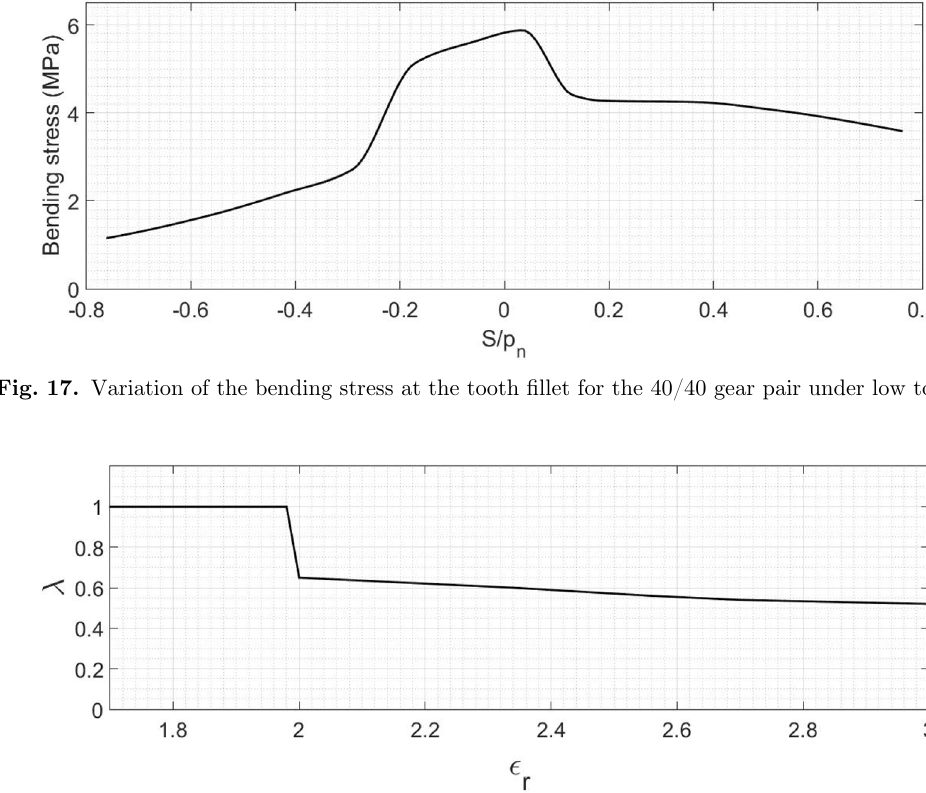
the tooth-root stress are shown in Figure 19.